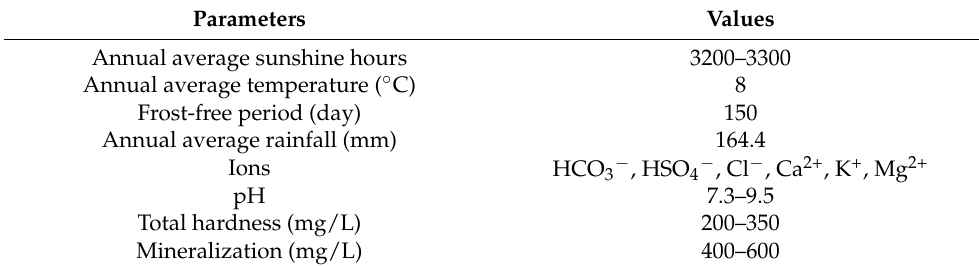
Table 1. Test site and water